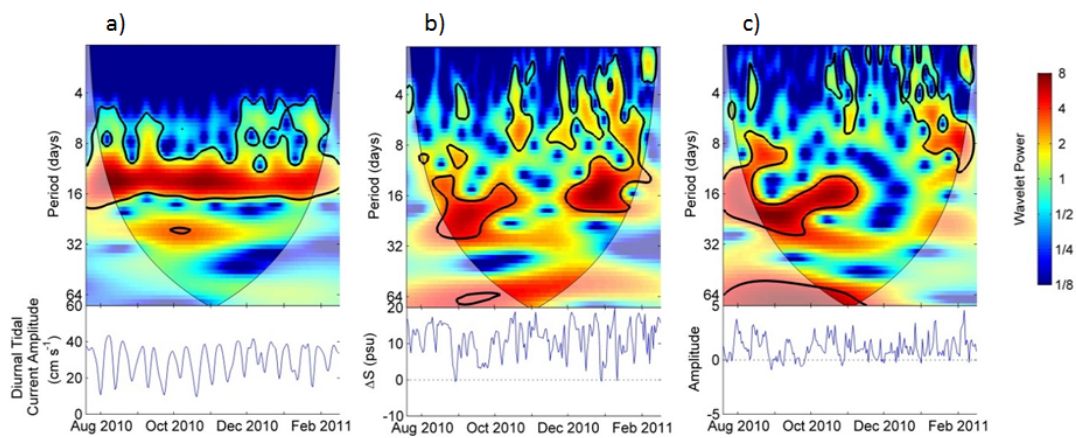
Figure 6. Wavelet power spectra (top) and time series plot (bottom) of diurnal tidal current amplitude